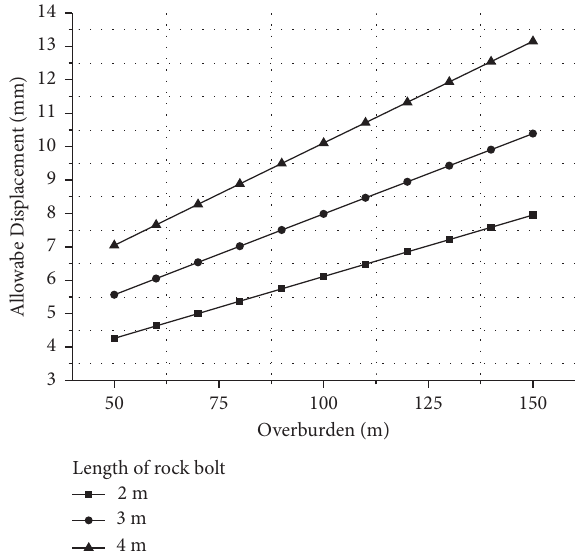
Figure 5: The curve of allowable displacement vs. tunnel